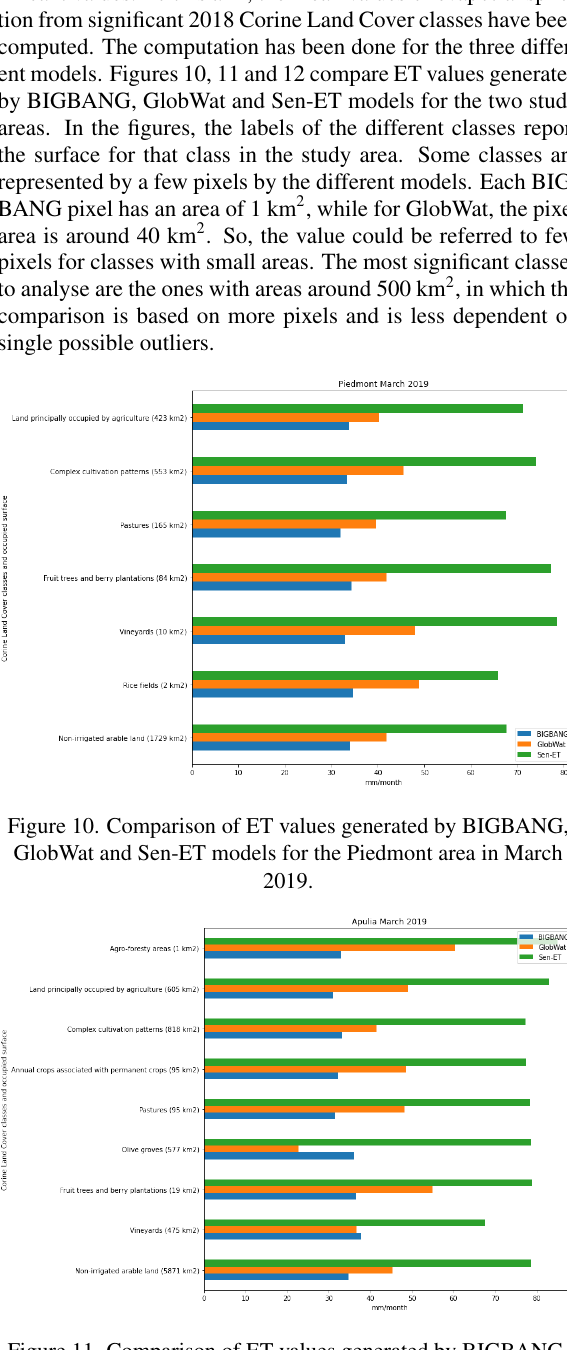
Figure 11. Comparison of ET values generated by BIGBANG, GlobWat and Sen-ET models for the Apulia area in March 2019.